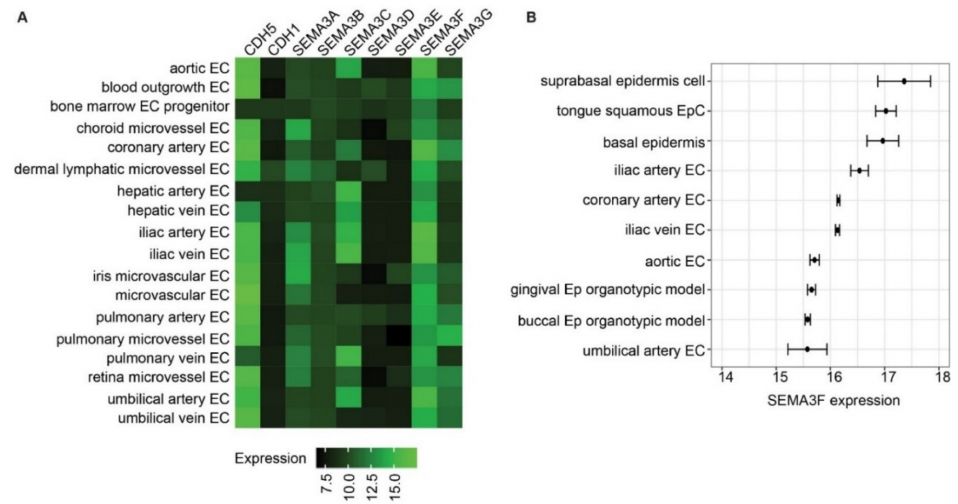
Figure 1. High expression of SEMA3F in various types of endothelial cells. ( A ) Heatmap of Class III semaphorin expression of all types of human endothelial cells profiled on A ff ymetrix Human Genome U133 Plus 2.0 Array platform (GEO accession: GPL570). Numbers indicate normalized microarray signals on log2 scale. Black color: lower expression and green color: higher expression. Expression signals of CDH5 and CDH1 were included as references. ( B ) SEMA3F expression in 10 human cell types with highest SEMA3F expression. Data is presented as mean ± SEM; n =